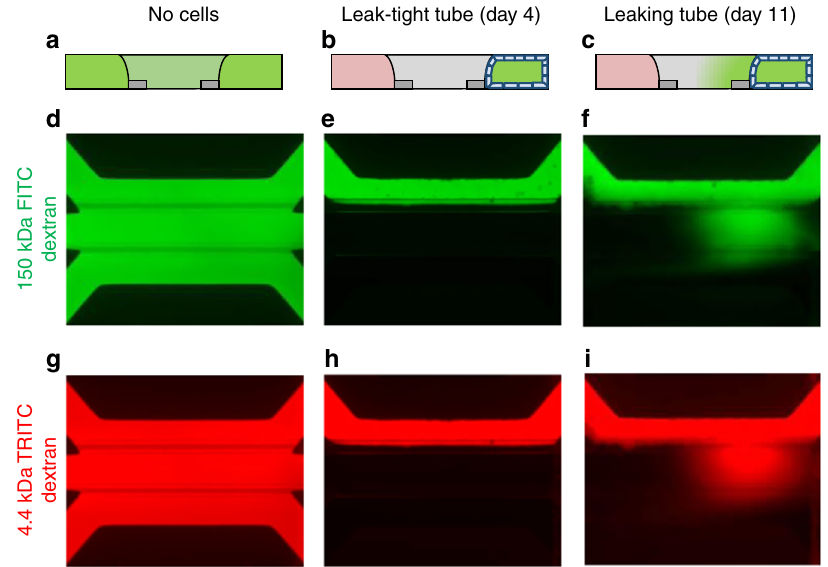
Fig. 3 Barrier integrity assay in OrganoPlate. A fl uorescent dye is inserted in the channel comprising the tube. Integrity of the tube barrier is quanti fi ed by measuring the amount of dye that is leaking out of the tube into the adjacent gel channel. a – c Sketch in vertical cross section showing fl uorescence distribution: a in absence of a tube, b for the case of a leak-tight tube and c for a leaky tube. d – i Fluorescent images of micro fl uidic chips perfused with fl uorescent molecules show experimental results for: gel only ( d , g ), leak-tight tube ( e , h ), and leaky tube ( f – i ) using both 150 kDa FITC-dextran and 4.4 kDa TRITC-Dextran during the same